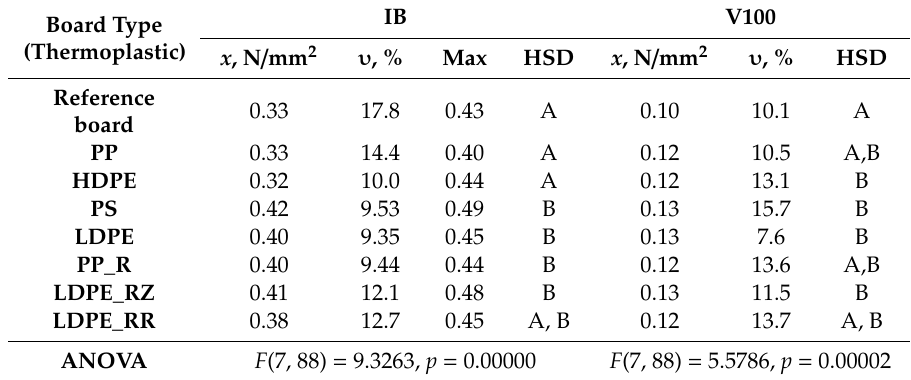
Table 4. E ff ects of the thermoplastics on tensile strength perpendicular to the board plane.